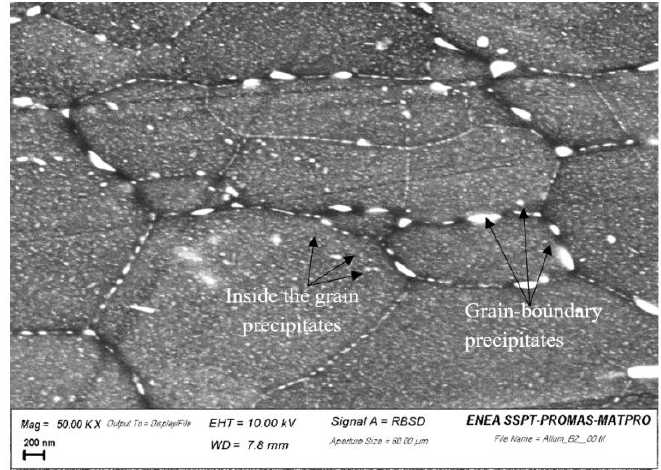
Figure 5. Example of the metallographic microstructure of sample A2 with grain-boundary precipitates (SEM-FEG image).